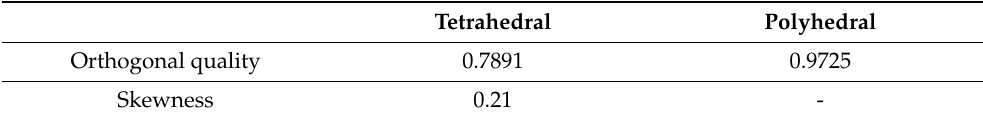
Figure 6. Skewness and orthogonal quality contours. Table 7. Averaged skewness and orthogonal quality for reflux chamber